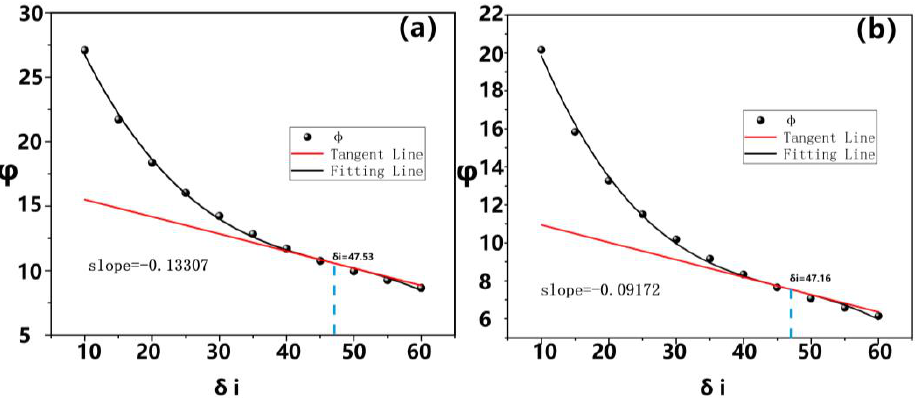
Figure 11. The impact of thickness on the ceiling energy-saving rate: ( a ) Ceiling energy-saving rate of “I-shaped” dwelling; ( b ) Ceiling energy-saving rate of “L-shaped” dwelling. For a typical “L-shaped” residential building, the change rate of the heat consumption ϕ of the ceiling energy-saving update was negatively correlated with the thickness of